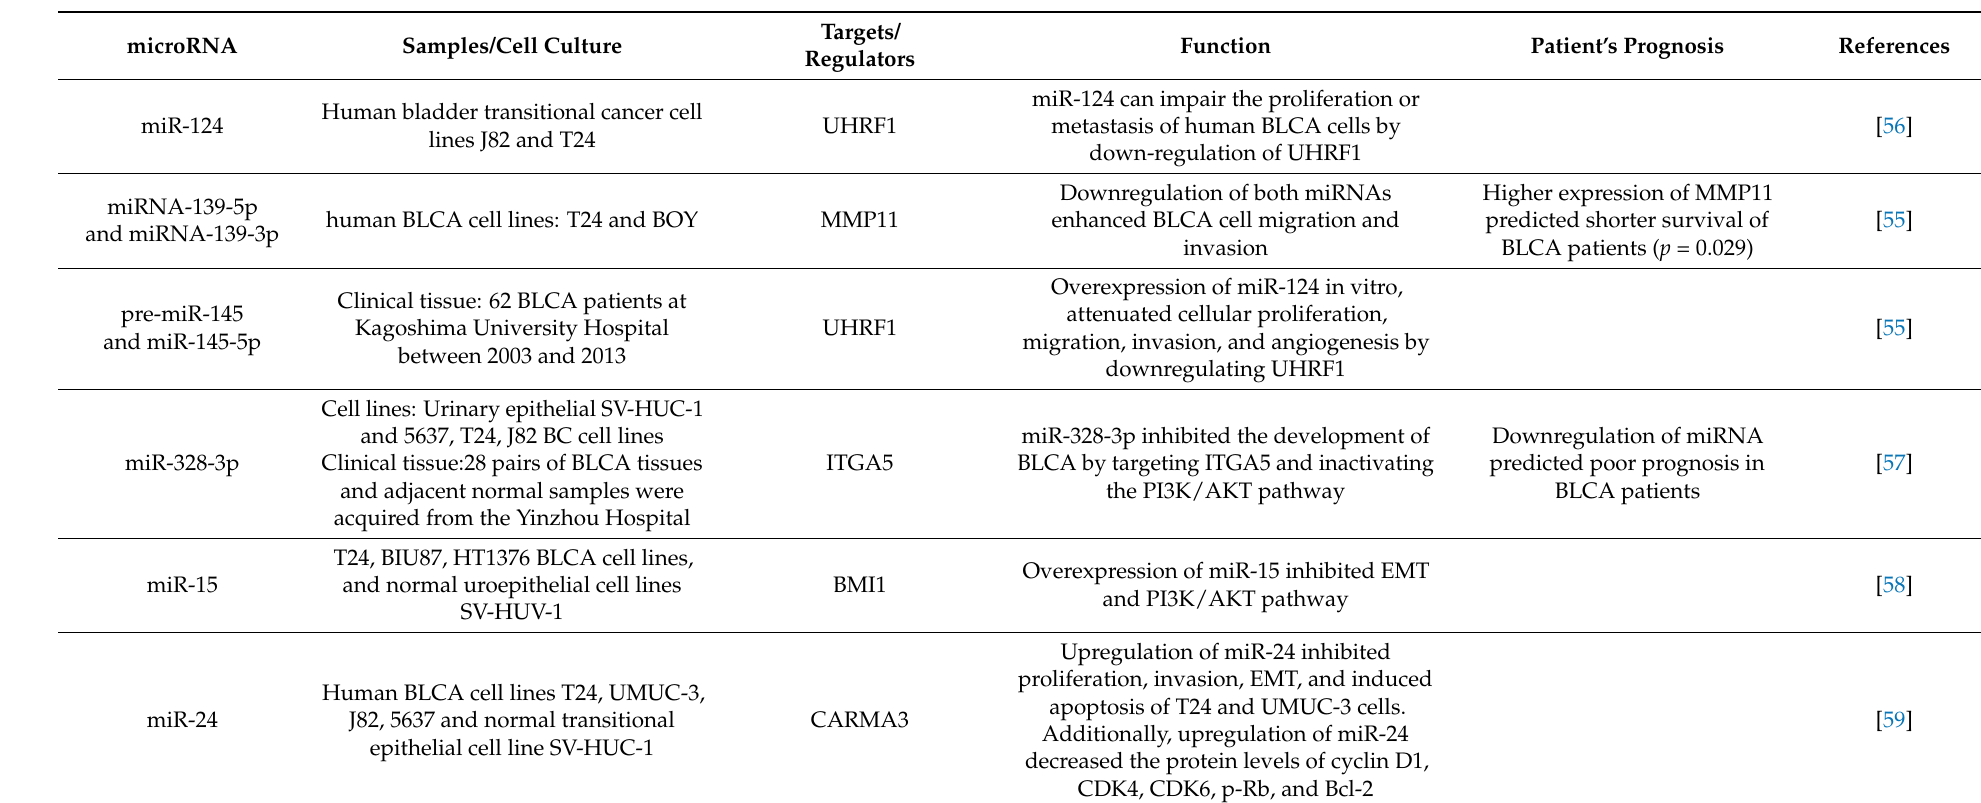
Table 3. miRNAs involved in metastasis induction/inhibition in